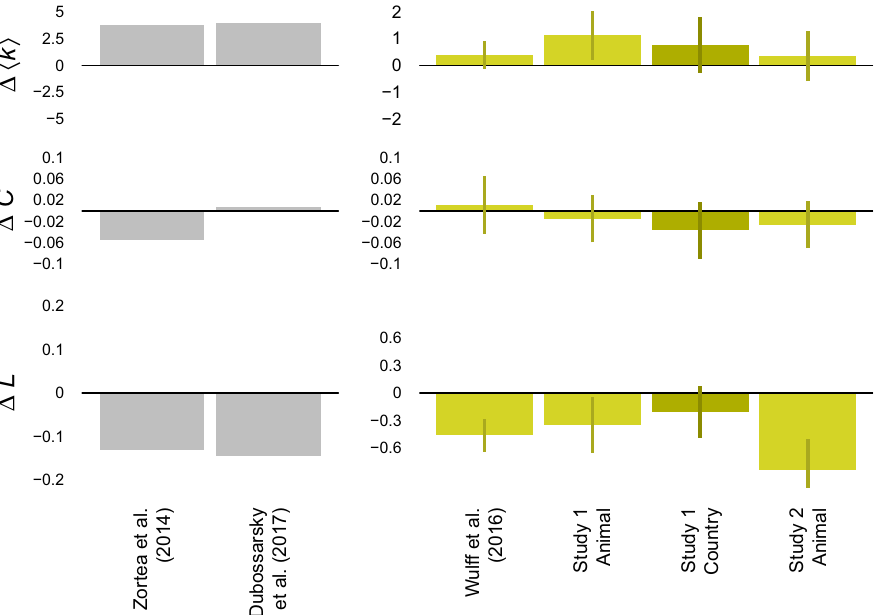
Figure 3. Differences in the macroscopic structure of younger and older adults’ fluency networks. Gray bars show the difference between the younger and older adults’ age group in Zortea et al. 40 and that of age 30 and 70 in Dubossarsky et al. 18 , respectively. Yellow bars show differences in networks inferred from the four fluency data sets. Error bars show 95% bootstrapped confidence intervals. Note: (cid:31) (cid:31) k (cid:30) -Differences in average degrees; (cid:31) C -Difference in average clustering coefficients; (cid:31) L -Difference in average shortest path